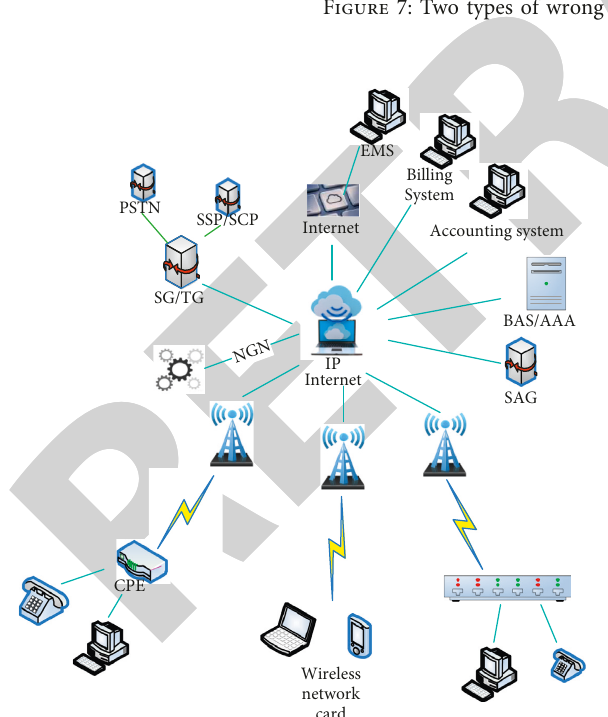
Figure 8: GPRS network structure diagram.